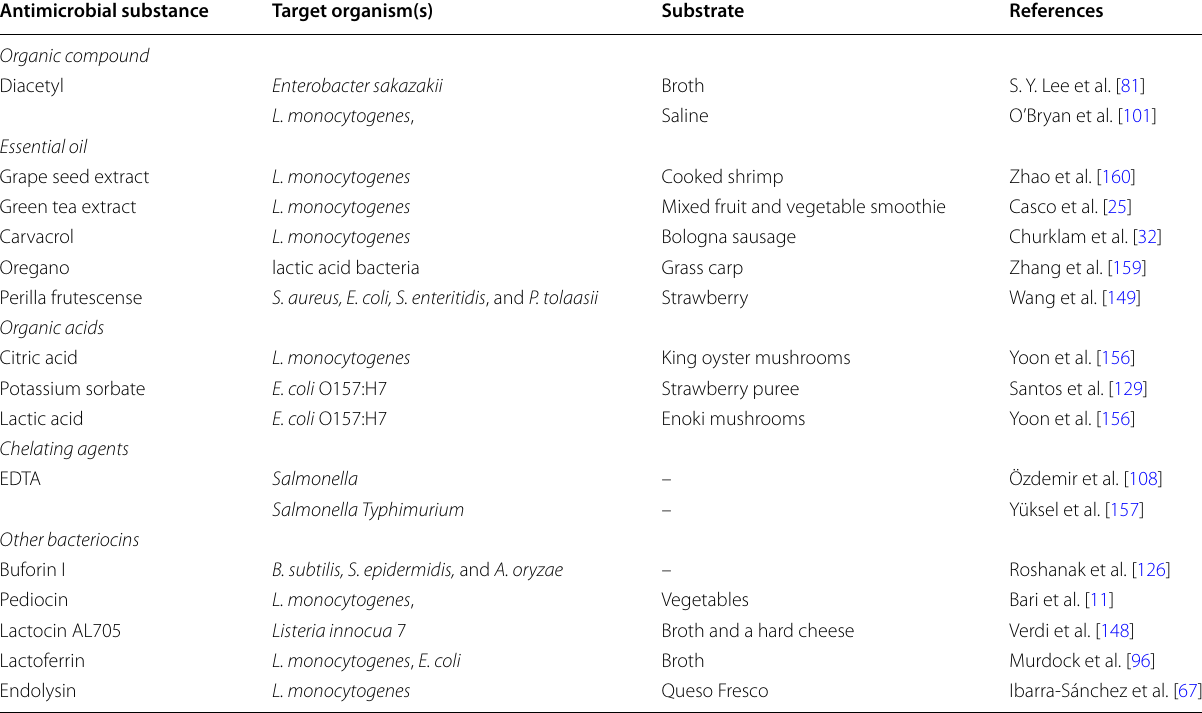
Table 2 Examples of antimicrobial substances showing dual antimicrobial inhibition with nisin Antimicrobial substance